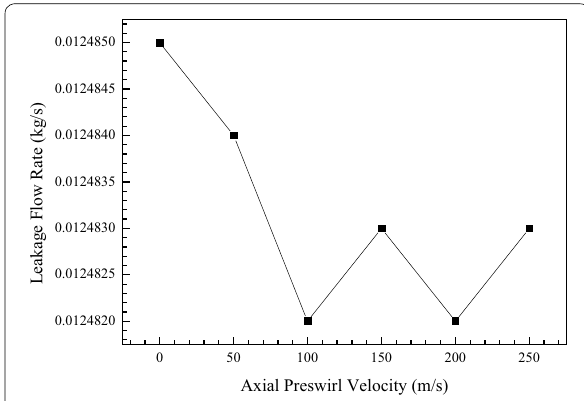
Figure 5 Leakage flow rate versus axial pre-swirl